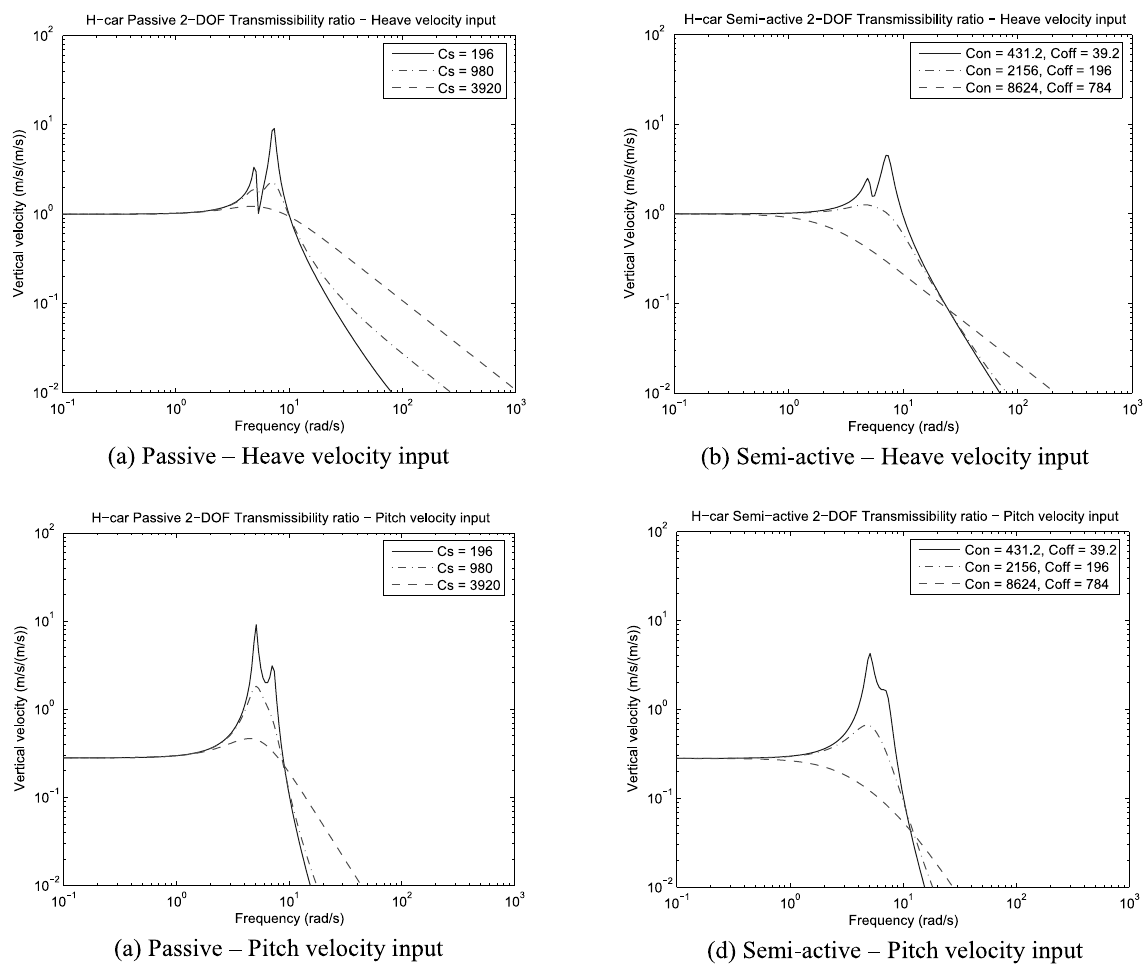
Fig. 3. Transmissibility ratio of vertical velocity for various damping